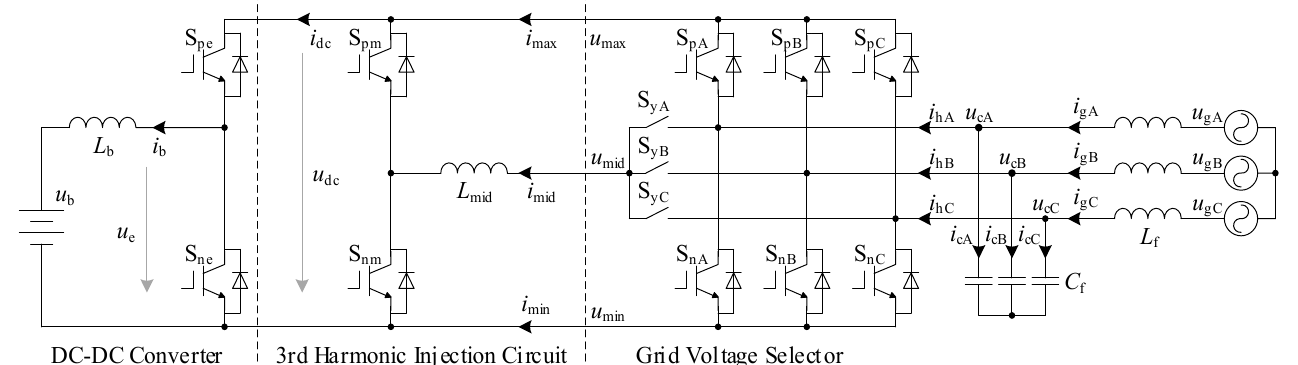
Figure 2. System topology of the proposed H3C-BESS.